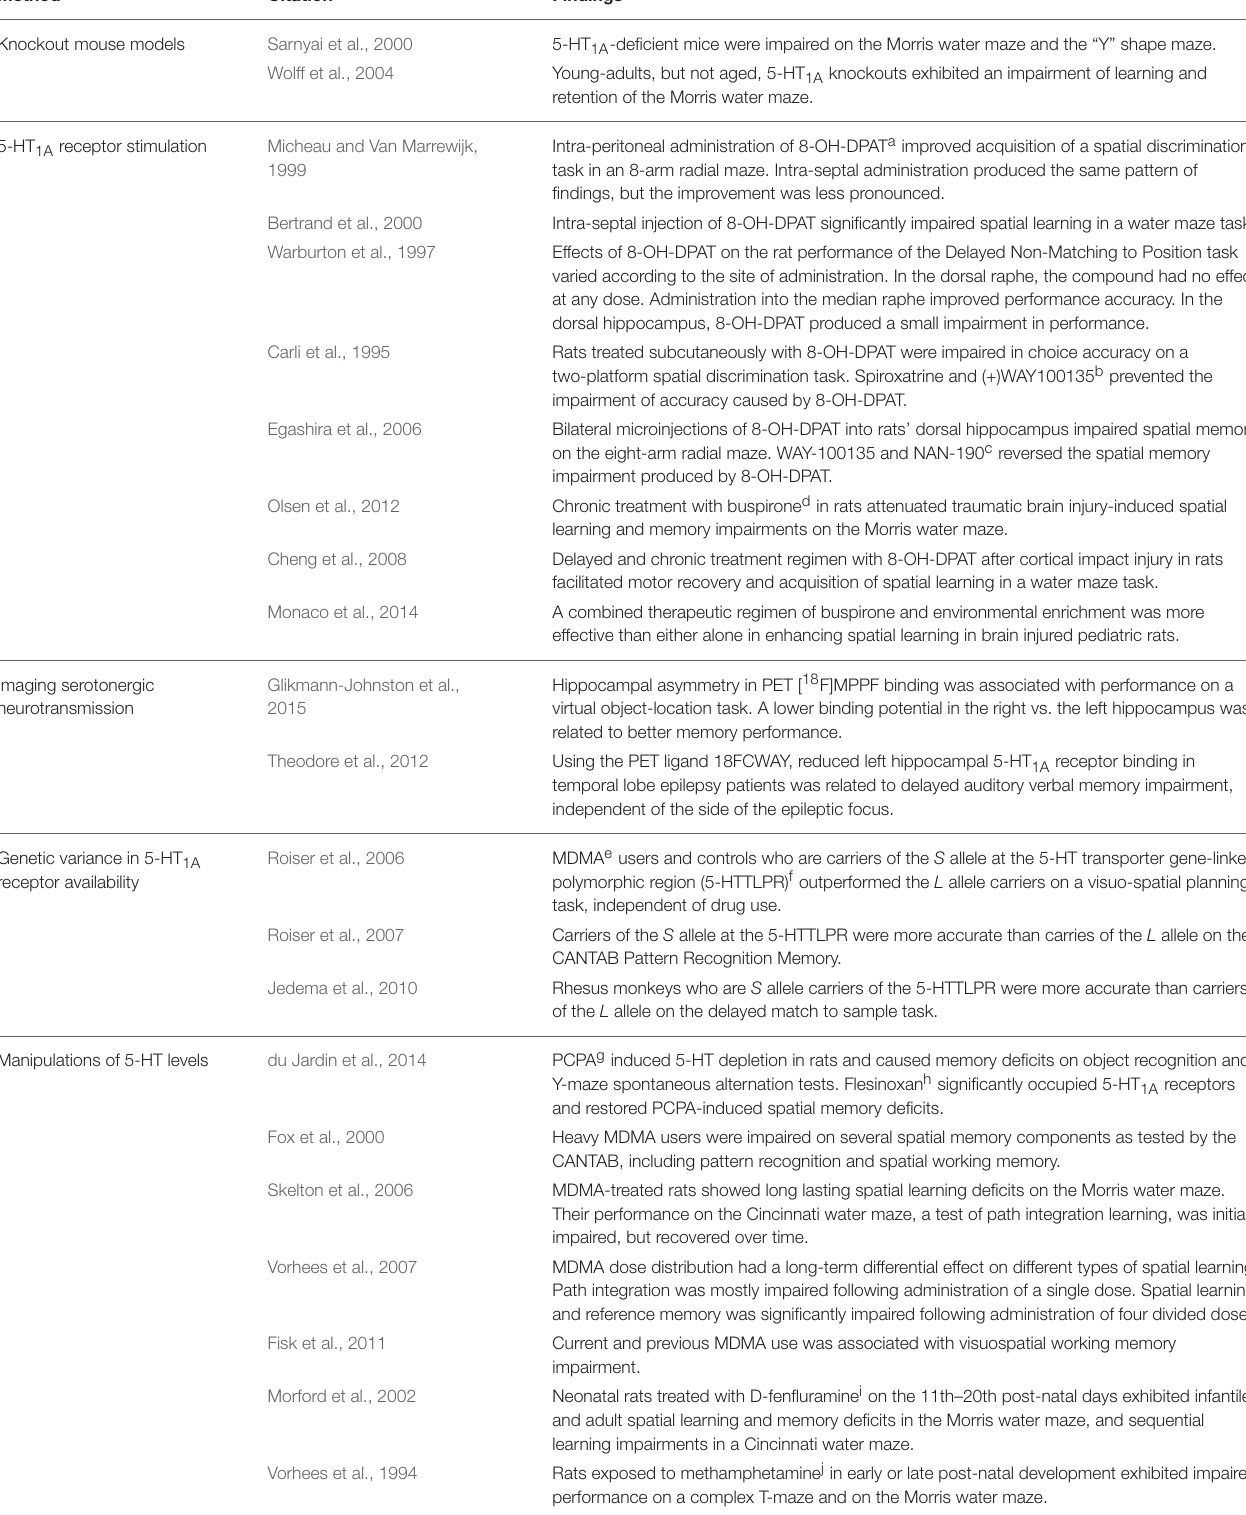
TABLE 1 | Summary of the studies cited according to the experimental method